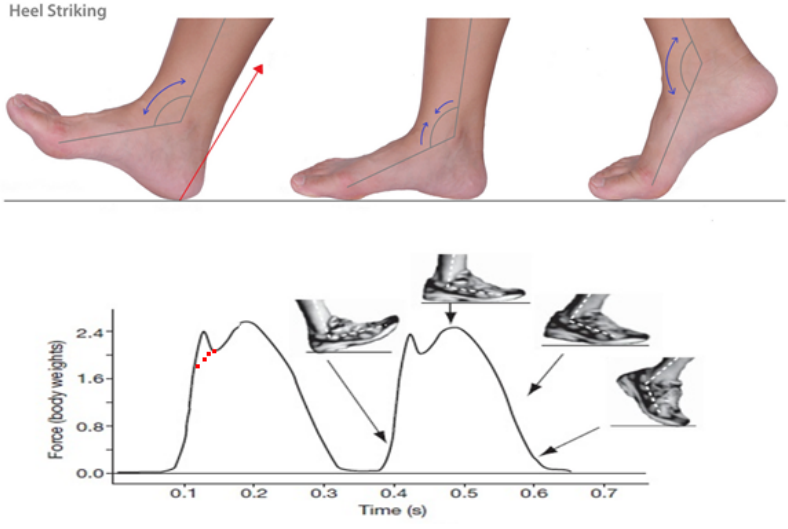
Figure 14. On the top, the movement of the foot. On the bottom, the forces exerted by different states of